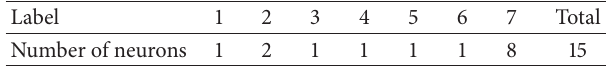
Figure 7: Relationship of cluster nodes number and vigilance parameters.